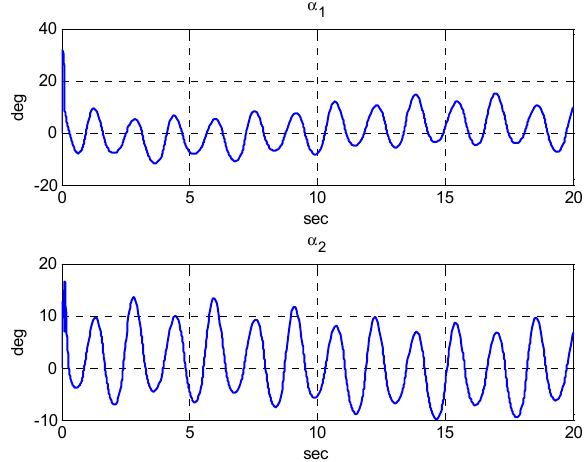
Figure 13. The tilt angle path with variable deviations and perturbations.